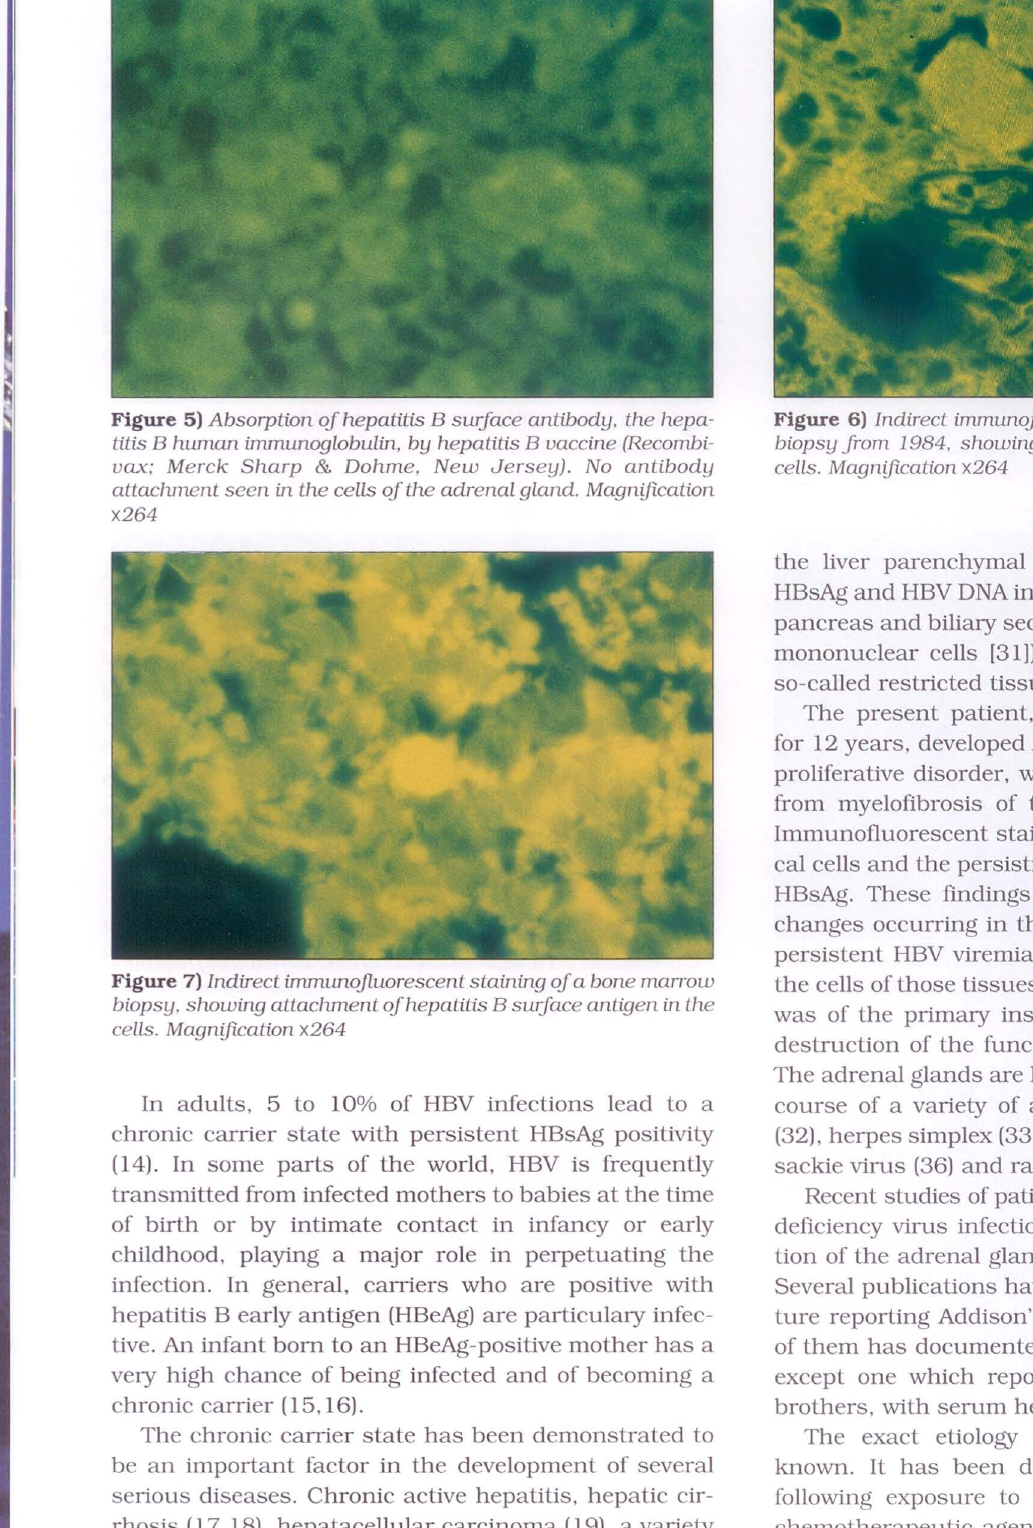
Figure 5) Absorption of hepatitis B surface antibody, the hepa titis B human immunoglobulin, by hepatitis B vaccine (Recombi